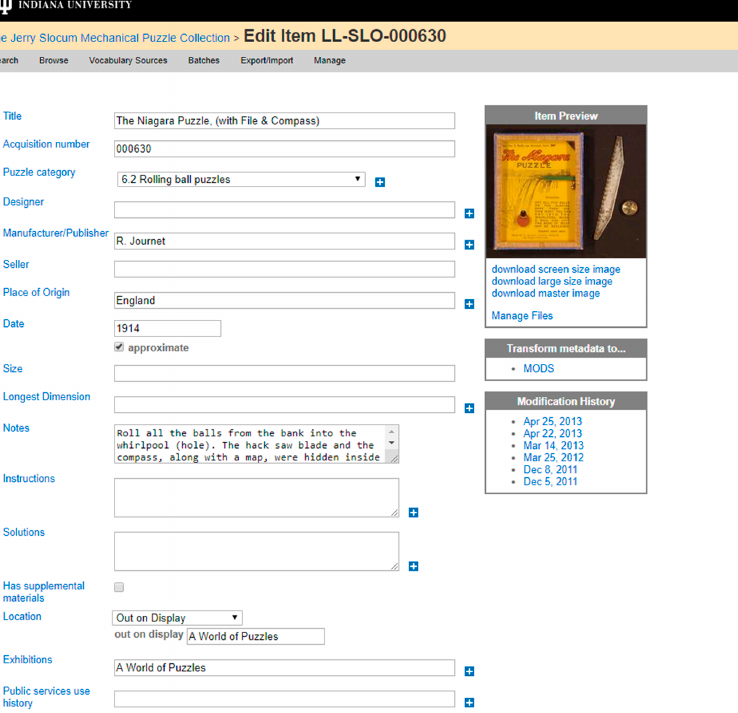
Figure 3. Screen shot of the administrative interface of Image Collections Online, with custom fields for descriptive metadata for each collection.